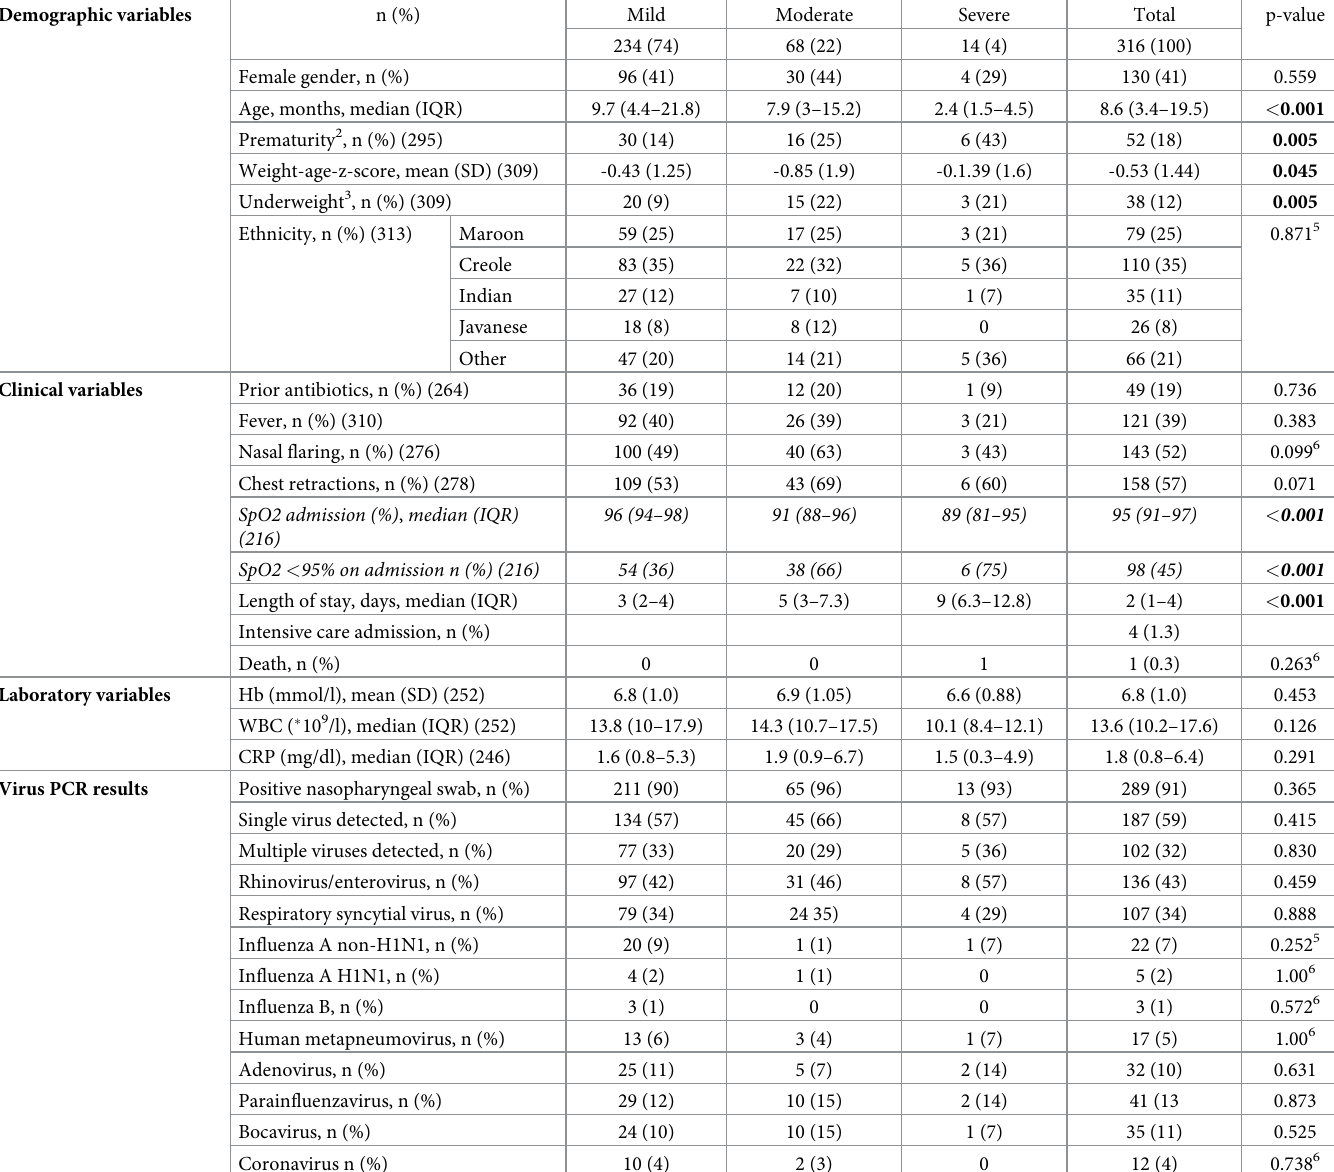
Table 1. Demographics of Surinamese hospitalized children (n = 316) with acute respiratory infections, categorized by maximum respiratory support received. Demographic